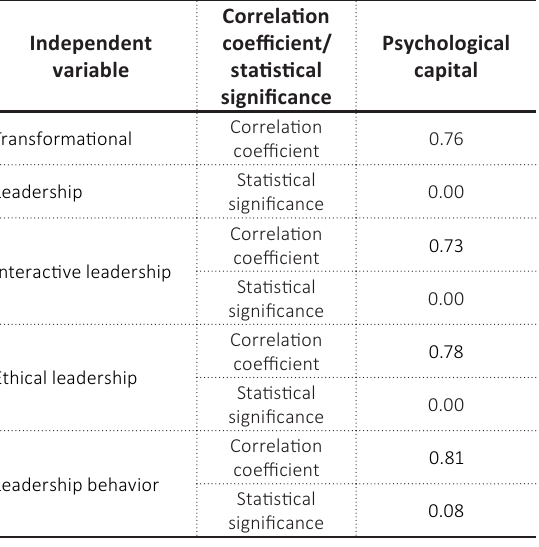
Table 5. Pearson correlation between leadership